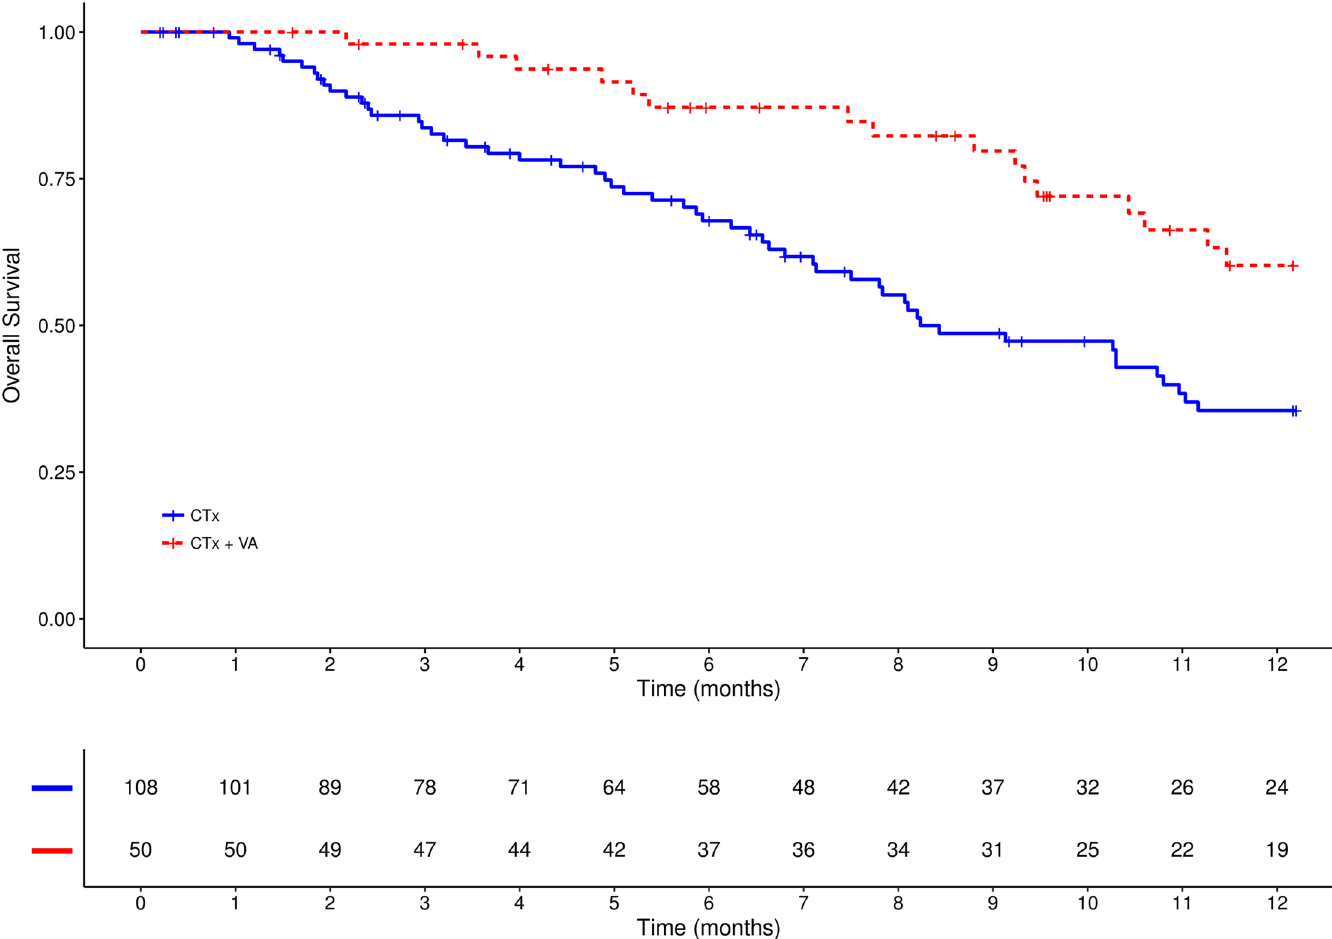
Fig 2. One-year survival. Kaplan–Meier survival curves displaying one-year survival in stage IV NSCLC patients treated either with CTx alone or with combinational CTx plus VA, n = 158; CTx, chemotherapy; VA, Viscum album L.